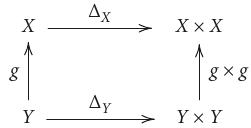
Figure 9: A commutative